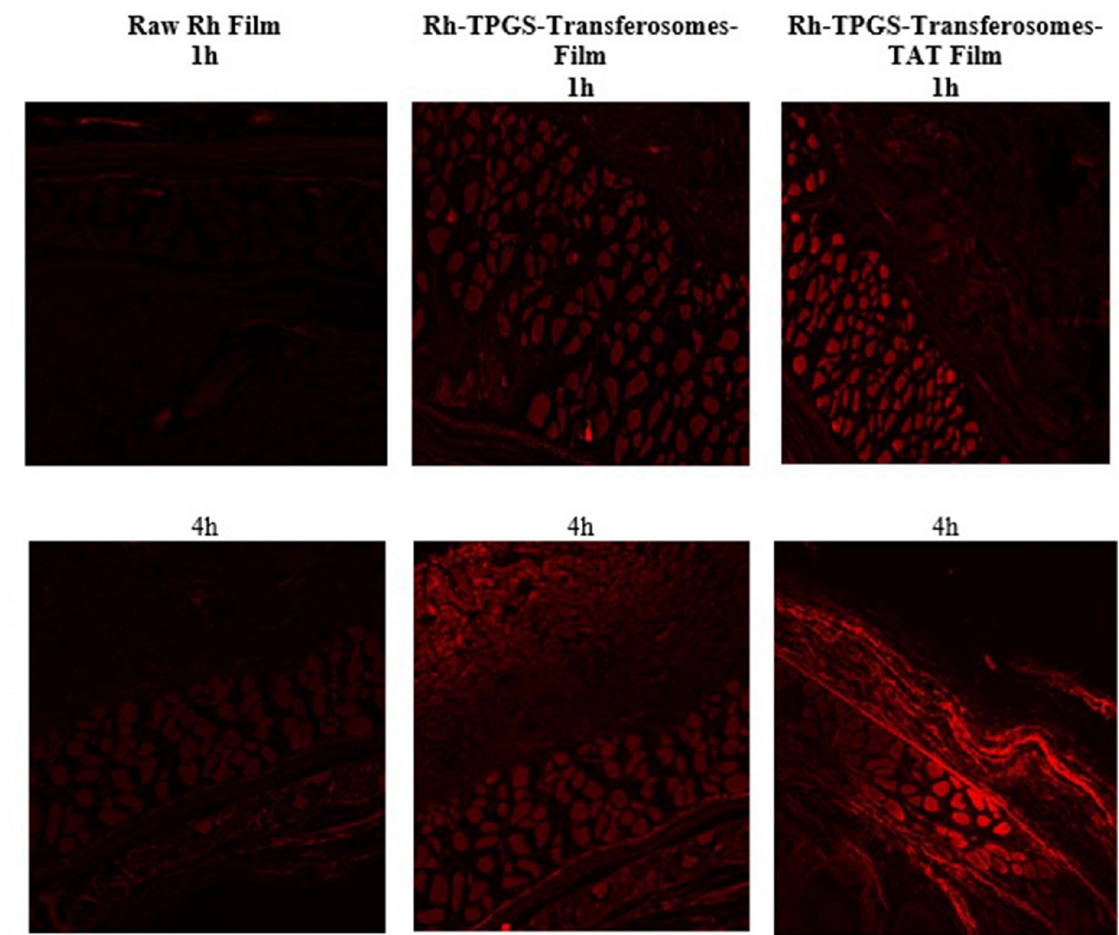
Fig 5. Fluorescence laser microscopy images for the permeation of raw Rh transdermal film (left column), and Rh-TPGS-Transferosomes Film (middle column) and Rh-TPGS-Transferosomes-TAT Film (right column) through rat skin after 1 and 4 hours. Magnification 400 ×